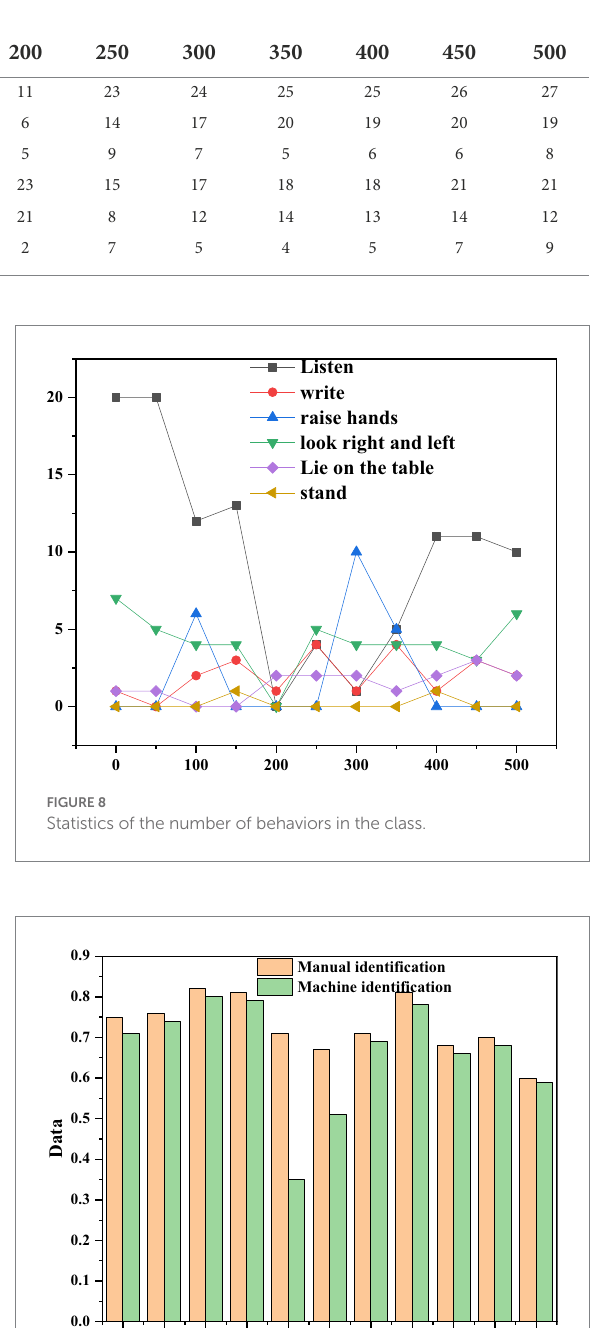
TABLE 9 The condition of students’ behavior in the classroom.